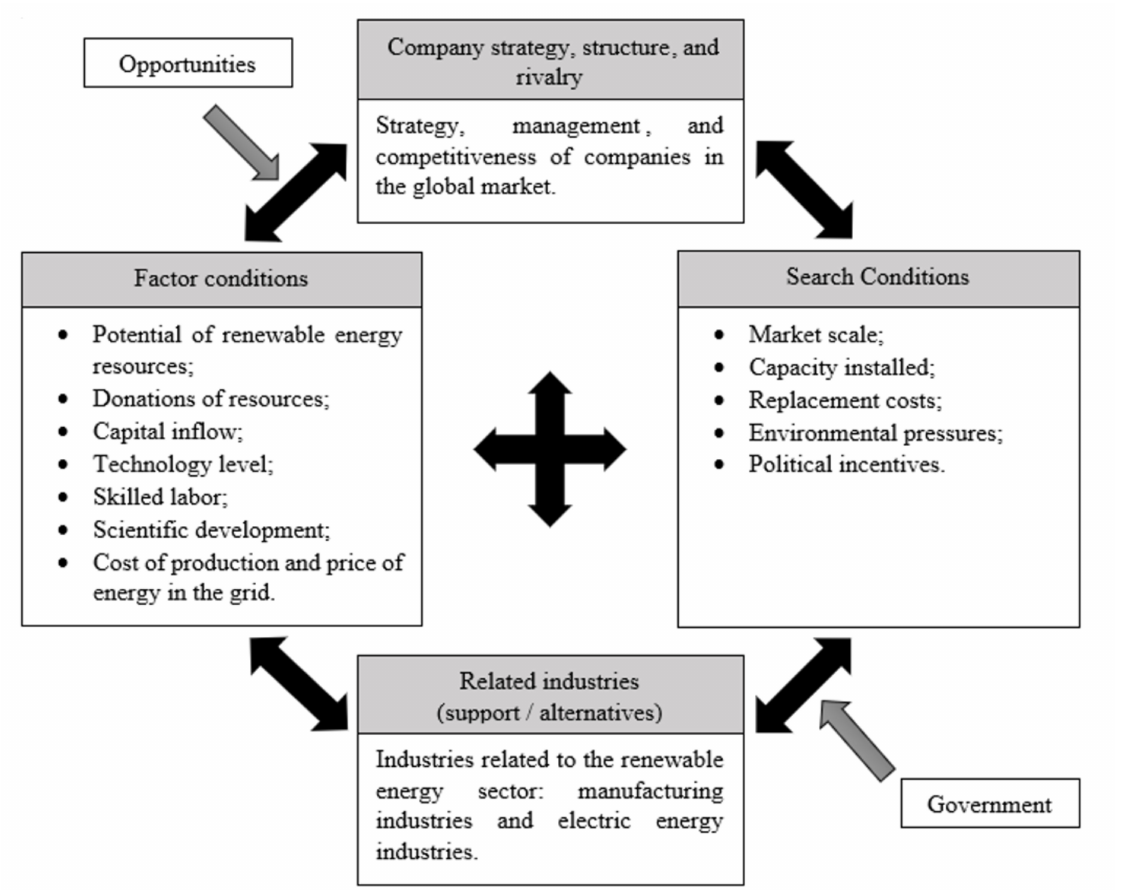
Figure 1. Porter’s Diamond model with application in renewable